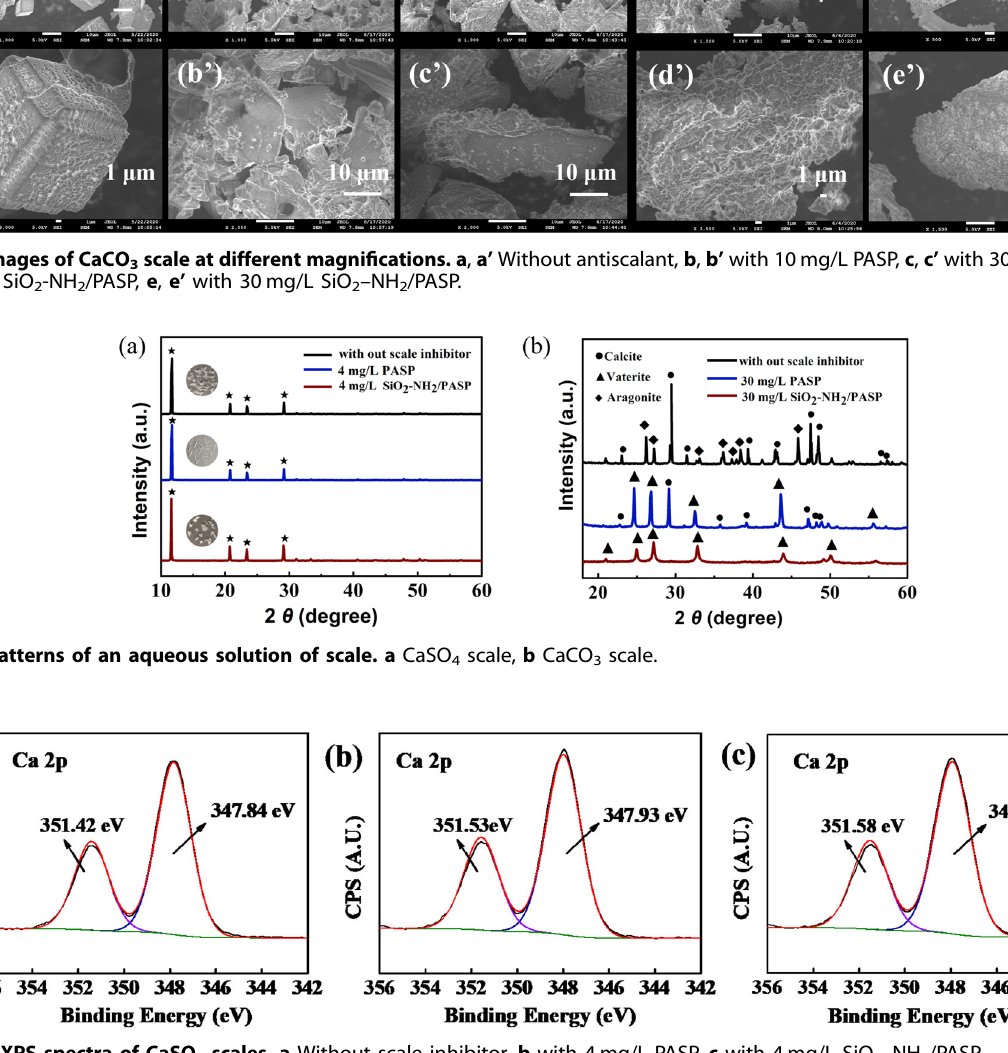
Fig. 8 Ca 2p XPS spectra of CaSO 4 scales. a Without scale inhibitor, b with 4 mg/L PASP, c with 4 mg/L SiO 2 – NH 2 /PASP.